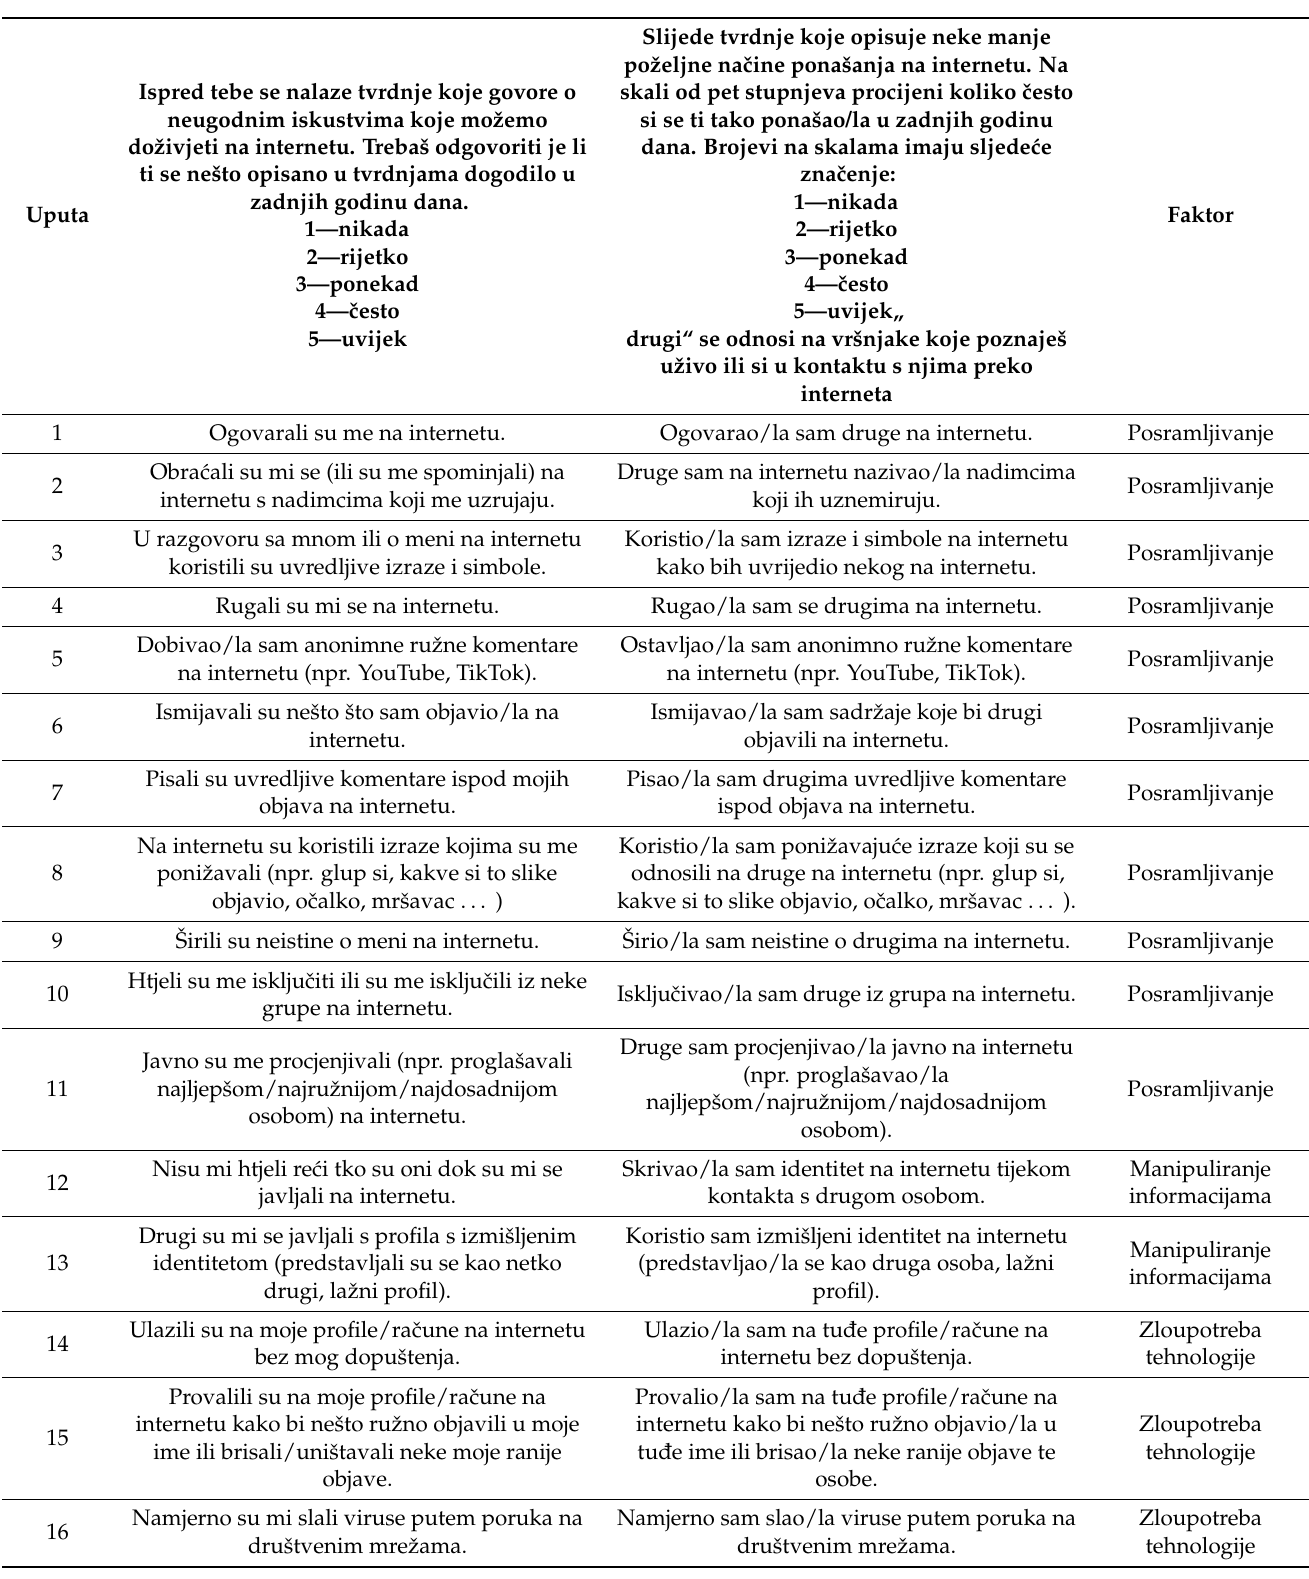
Table A2. Skala ˇcinjenja i doživljavanja nasilja preko interneta—2021 (S ˇCDNI-2021, Šincek, 2021).